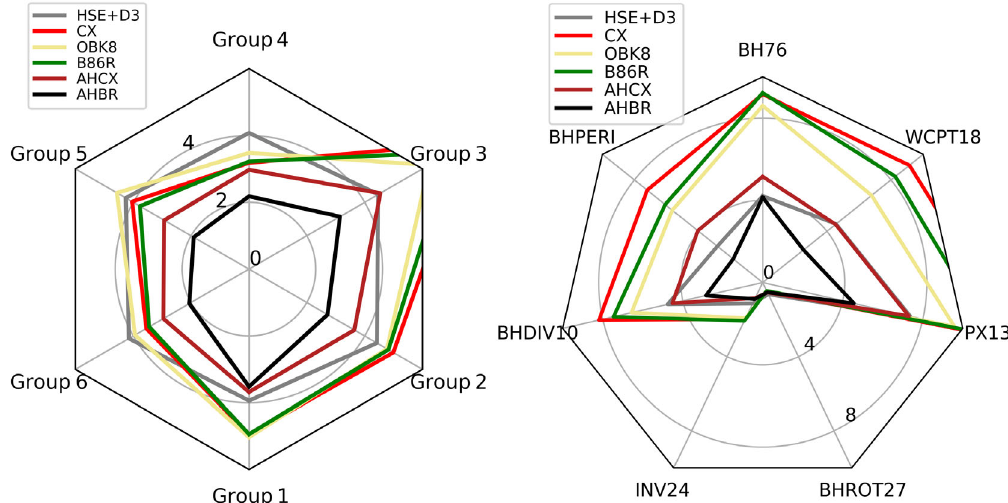
FIG. 1. Performance comparison of vdW-DFs as averaged over the six groups of molecular benchmarks in the GMTKN55 suite [69] (left panel) and as tracked for individual transition-state benchmark sets of group 3 (right panel): barrier-height benchmarks for small and cyclic molecules (with labels BH76 and BHPERI), for diverse, inversion, and rotation processes (with labels BHDIV10, INV24, and BHROT27, respectively), as well as for proton exchange and transfer problems (labels PX13 and WCPT18). The GMTKN55 suite also probes performance on small-system reaction energies (group 1), large-system reaction energies and isomerizations (group 2), as well as total, inter-, and intramolecular noncovalent interactions (groups 6, 4, and 5, respectively). We report mean absolute deviations (MADs) in kcal/mol compared with coupled-cluster reference energies at reference geometries [69]. For comparison, we also include an assessment of dispersion-corrected HSE þ D 3 [69,93 – 95] and the recently defined RSH vdW-DF-ahcx (abbreviated AHCX) [17]. Regular functionals exemplified by the three vdW-DFs with best overall molecule performance, CX [10], B86R [56], and vdW-DF- optB88 (or optB88-vdW, abbreviated OBK8) [57], are often challenged by density-driven DFT errors [90] in such